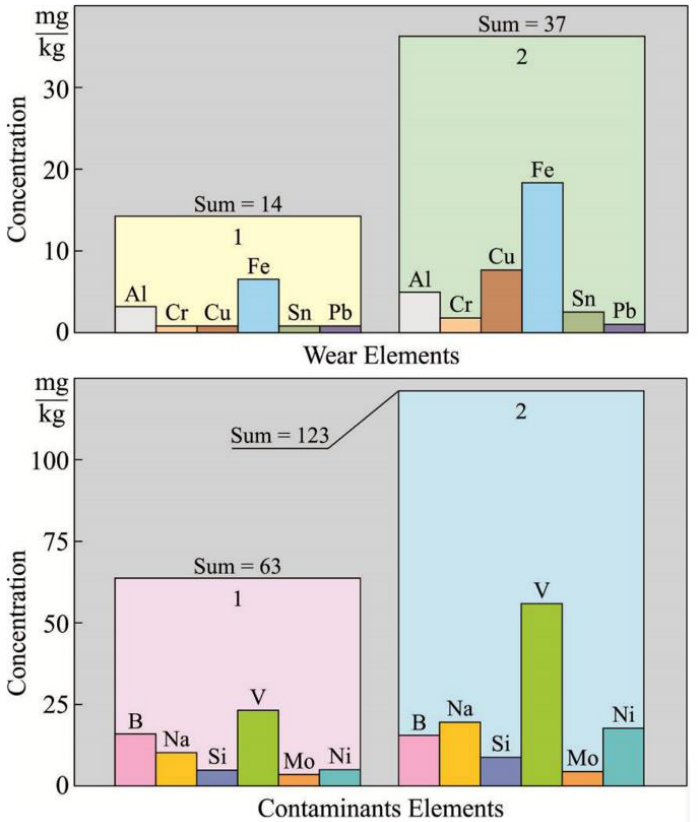
Figure 7. Results of spectral analysis of oil Shell Gadinia AL 40 under different experimental